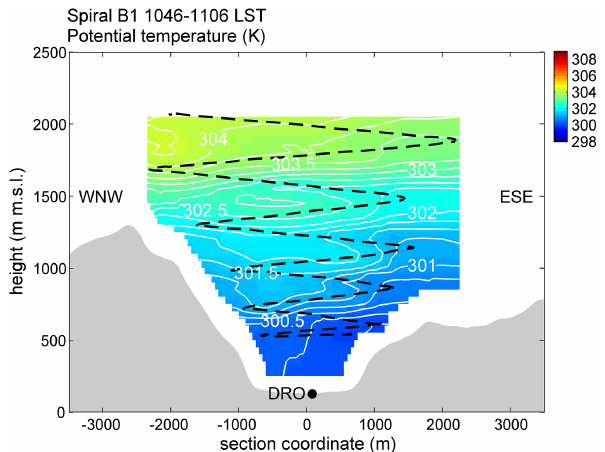
Figure 9. As in Fig. 7 but for spiral B1. The horizontal coordinate marks the cross-valley direction. The projection of DRO’s position is also indicated (black